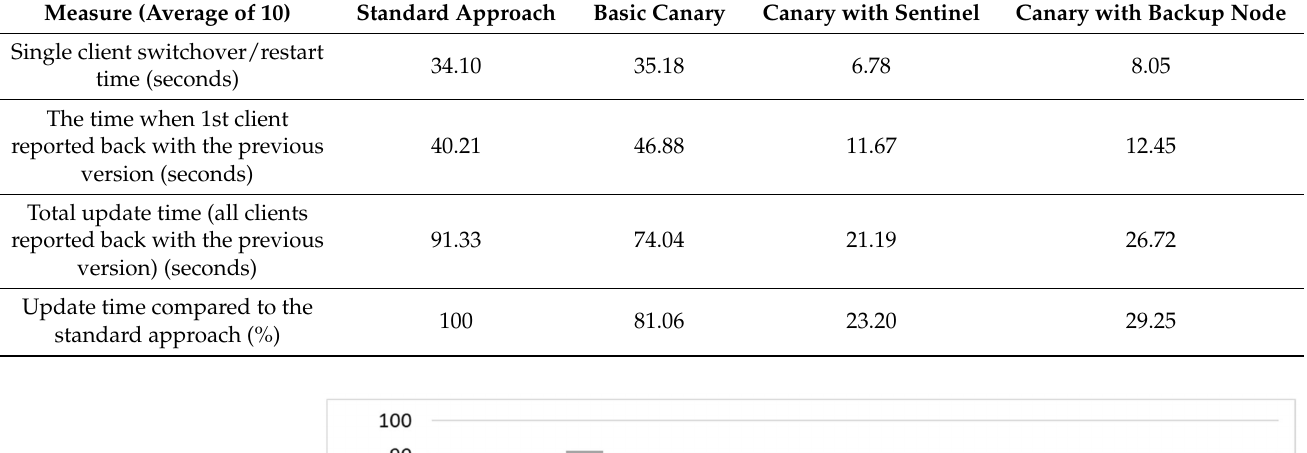
Table 4. Effects of different client deployment approaches (roll back needed case).